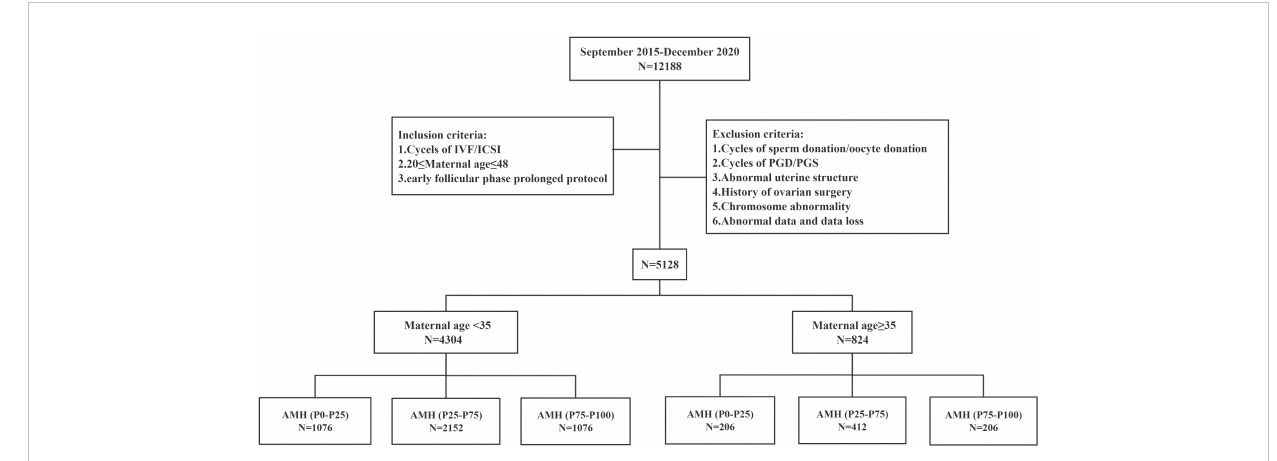
FIGURE 1 Flow chart of the study